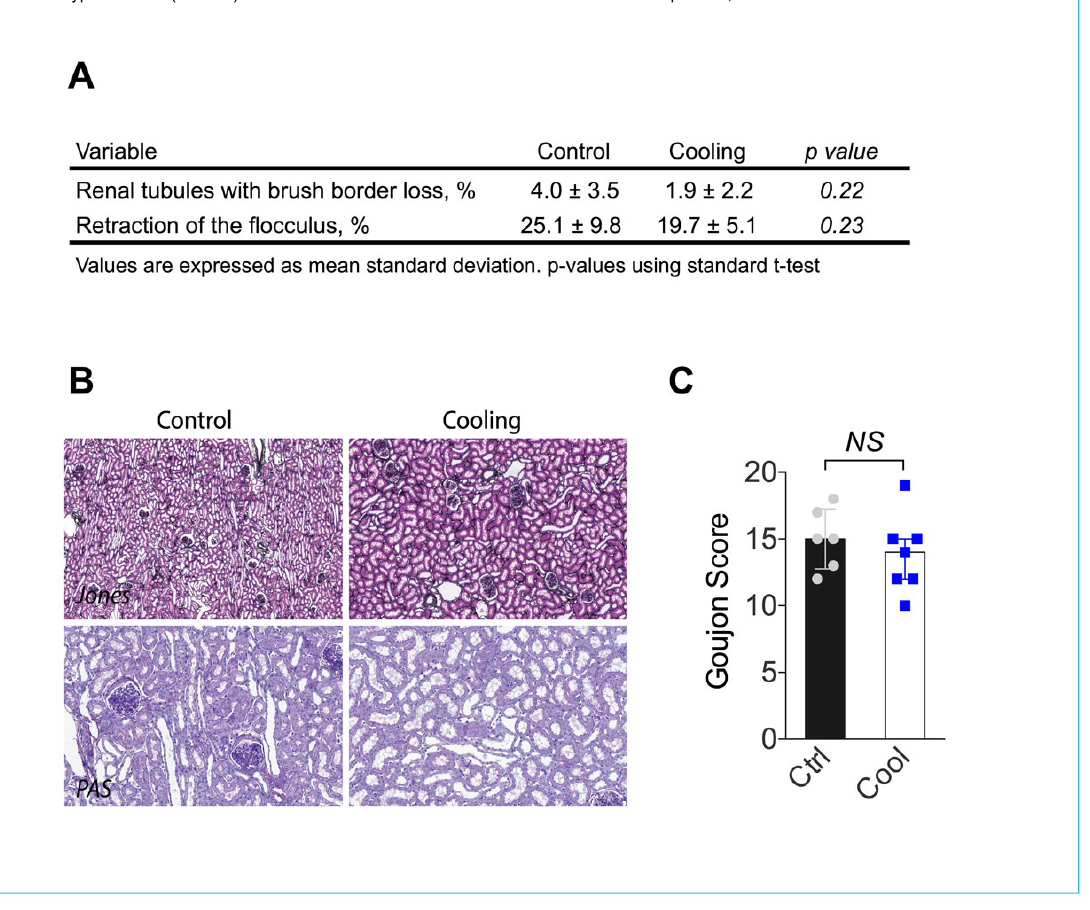
Figure 4: Histological analyses following kidney reperfusion. (A) Percentage of lumina of tubules with cellular debris, the percentage of brush border loss, tubular dilatation, and percentage of floculus retraction in Bowman's space. (B) Representative kidney histological sections